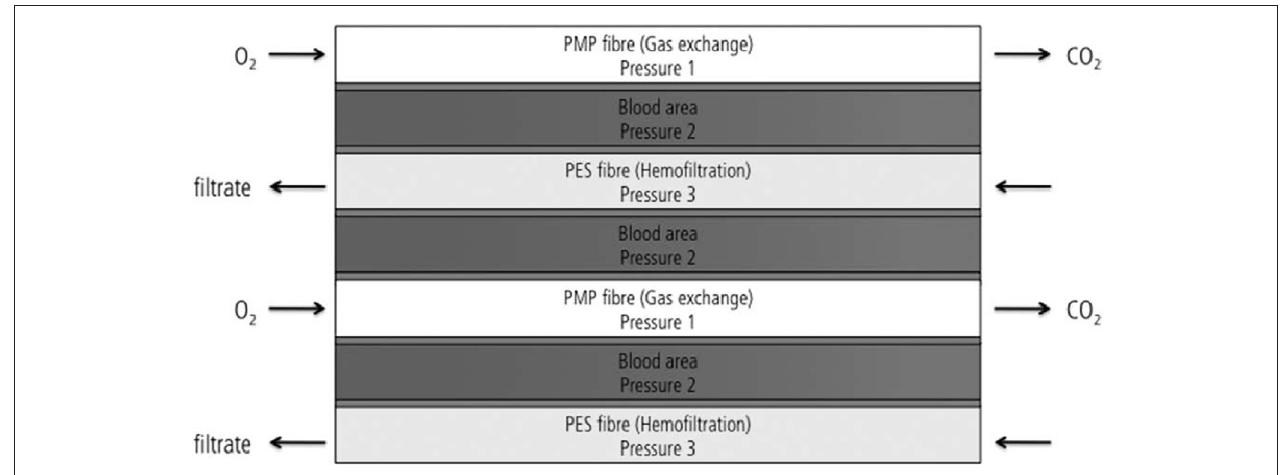
FIGURE 11 | Design of the modified iLA membrane oxygenator combining 50% of oxygenation and 50% of hemofiltration fiber